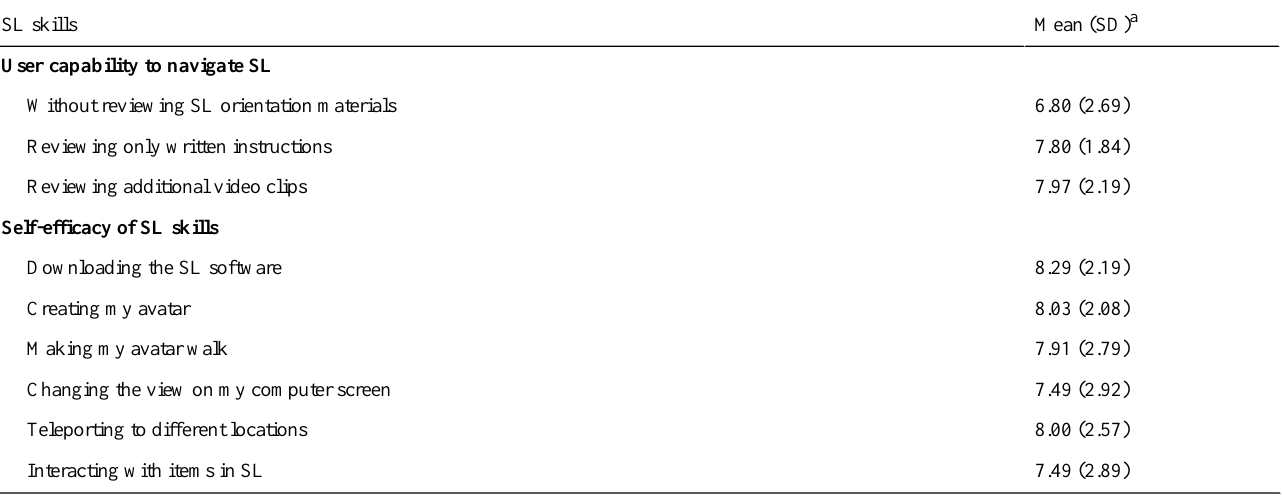
Table 1. Evaluation of SL orientation manual and self-efficacy of SL skills